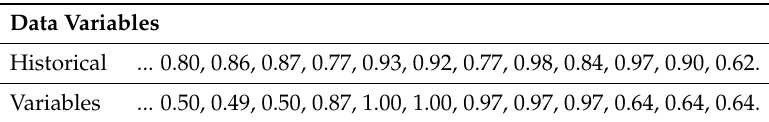
Table 2. Historical data.